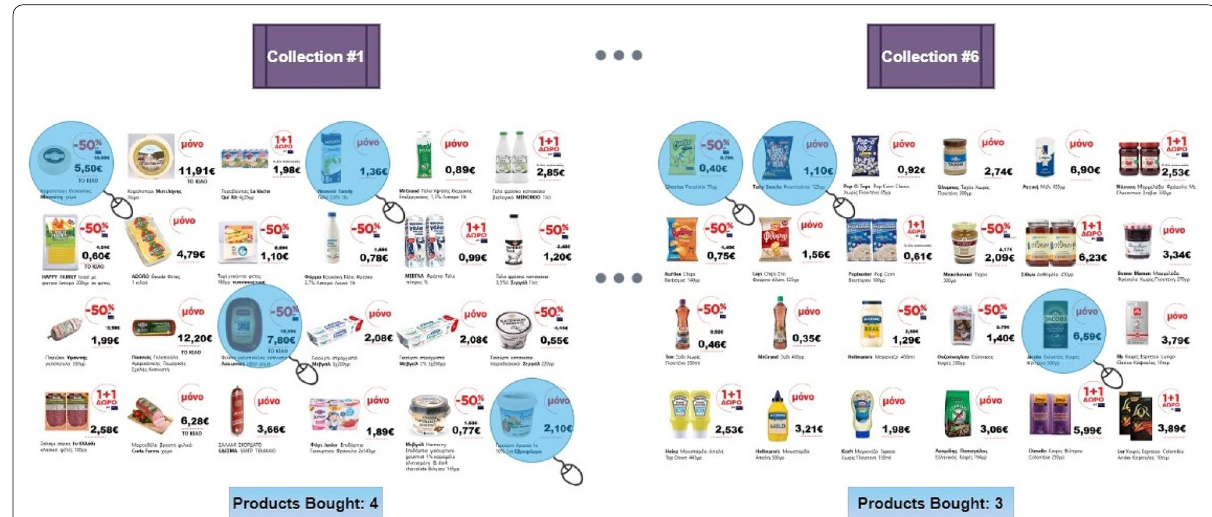
Fig. 2 Experimental protocol for the static dataset. Six different image collections were delivered to the participant, who was allowed to select products from each collection without any